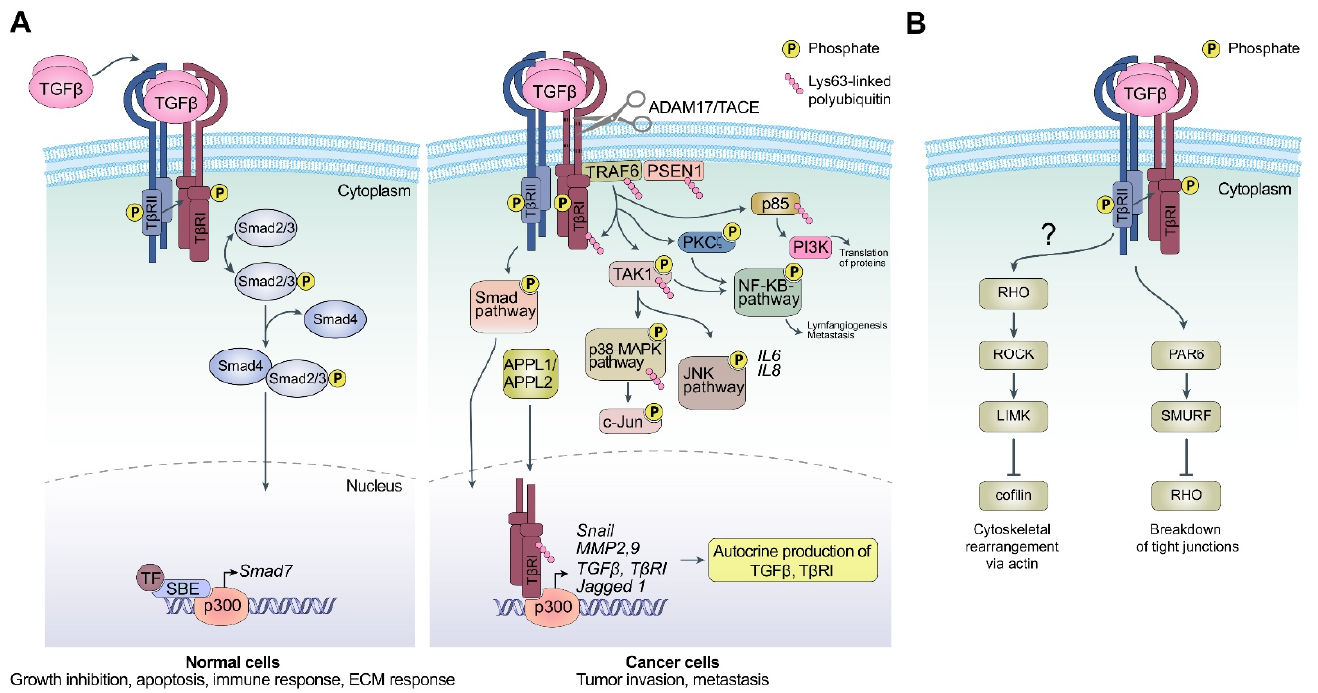
Figure 1. ( A ) A graphical illustration of canonical (left) and non-canonical (right) TGF- β signaling. In canonical TGF- β signaling, TGF- β ligand binds to TGF β RI (T β RI) and TGF β RII (T β RII) receptors, resulting in their activation in a hetero-tetrameric complex. The intracellular Smad2/3 are next activated by phosphorylation, initiated by TGF β RI; pSmad2/3 form a complex with Smad4 and, together with certain transcription factors (TF), activate specific targets genes that contain Smad- binding elements (SBEs), implicated in growth inhibition, apoptosis, ECM synthesis, and immune response. In the non-canonical signaling pathway, TGF- β induces the expression of TRAF6 and ubiquitinates it in a Lys63-dependent manner, promoting its catalytic activity. TRAF6 then activates TACE and PSEN1, resulting in the proteolytic cleavage of TGF β RI, generating the soluble TGF β RI intracellular domain (TGF β RI-ICD/ T β RI-ICD). The endosomal adaptor proteins APPL1/APPL2 and intact microtubules are required for the translocation of TGF β RI-ICD to the nucleus, where it contributes to activating specific target genes. Other modes of non-canonical TGF- β signaling pathways are also shown. Adapted from [43,44,46–51,54]. ( B ) TGF- β signaling can also induce EMT through the activation of non-Smad pathways such as Rho GTPase and via the phosphorylation of the polarity protein PAR6, leading to cytoskeletal rearrangements and the breakdown of epithelial cell junctions, respectively. Adapted from